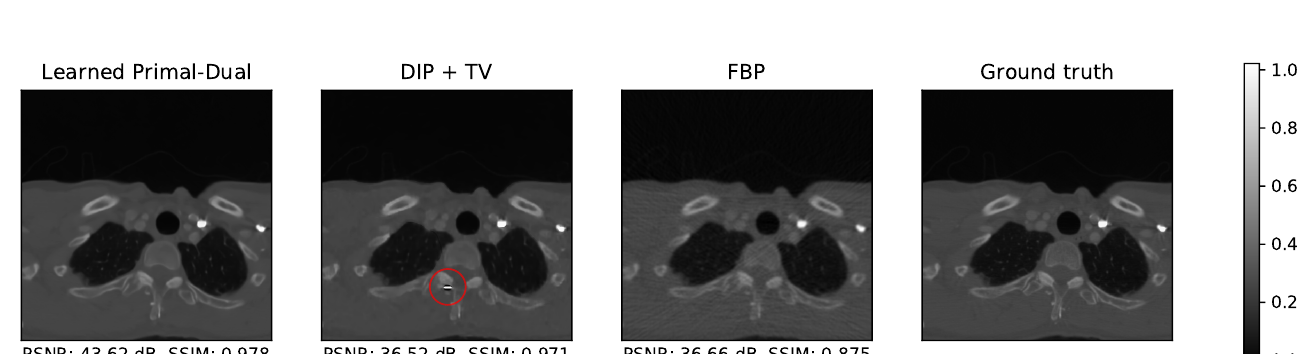
Figure A9. Example of an artifact produced by DIP + TV, which has only minor impact on the evaluated metrics (especially the SSIM). The area containing the artifact is marked with a red